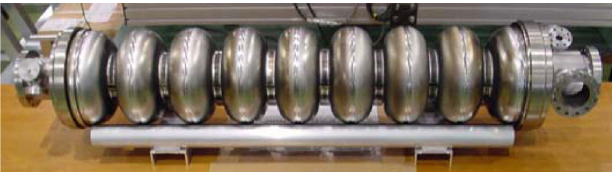
FIG. 1. (Color) Tesla-like nine-cell niobium cavity developed